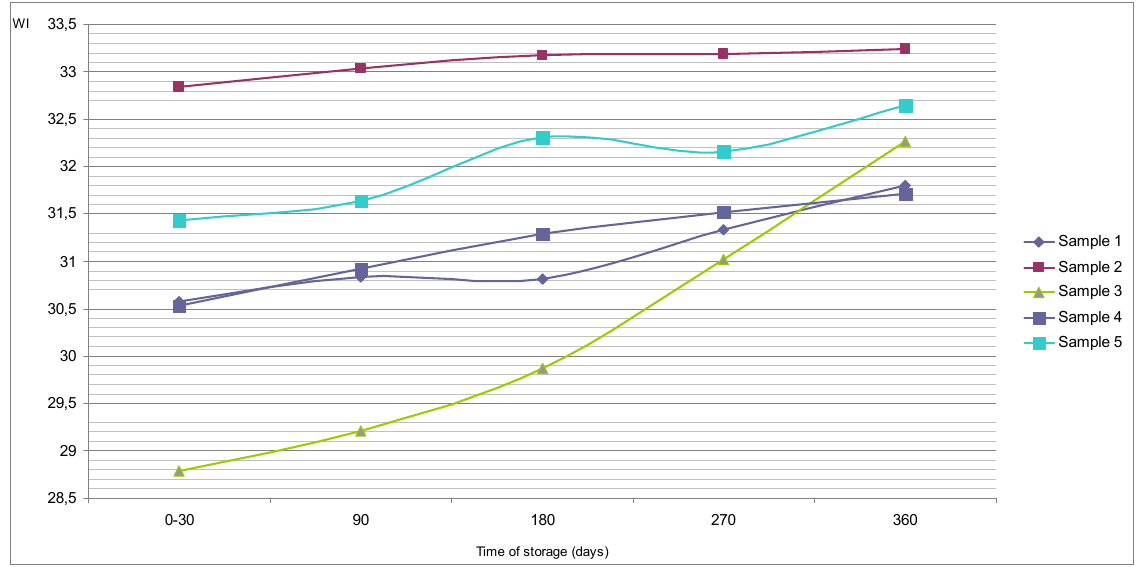
Figure 7. Changes of whiteness index (WI) on the bottom surface of samples of dietary chocolates during storage of 360